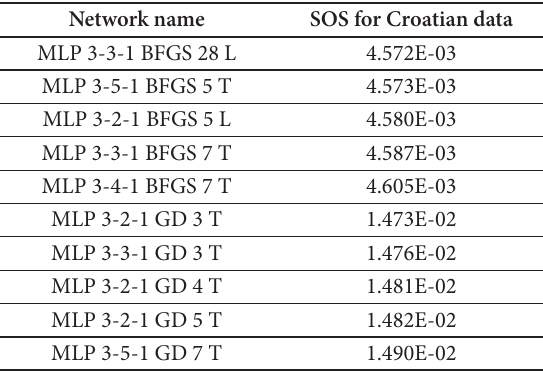
Table 4. Results on Croatian